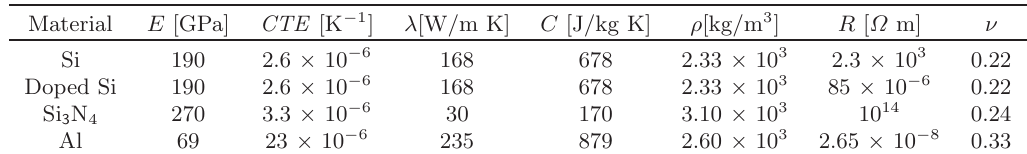
Fig. 3. General view of the microscanner: a) during the forming process, b) after the forming process. Table 1. Material